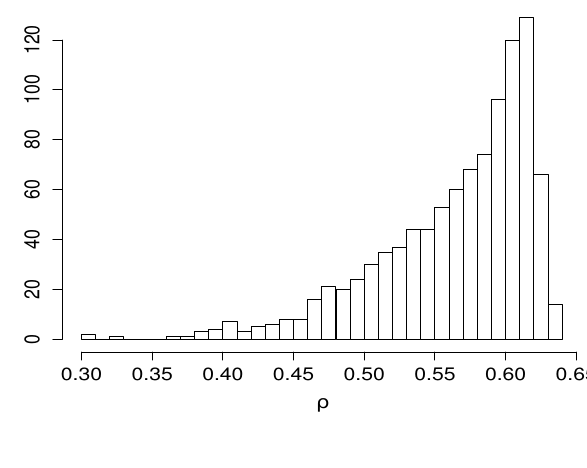
Figure 4 { Hybrid method: \posterior" distribution of ^ φ ( λ